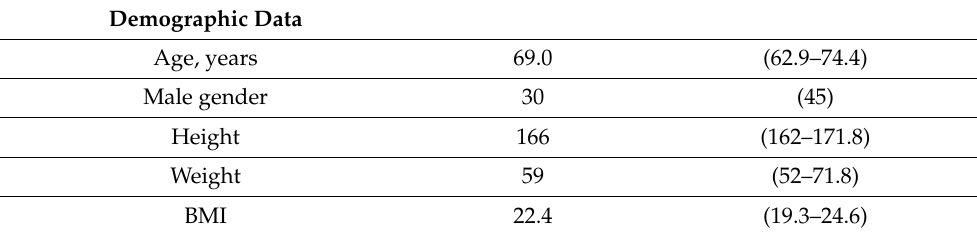
Table 1. Baseline characteristics of all patients ( n =